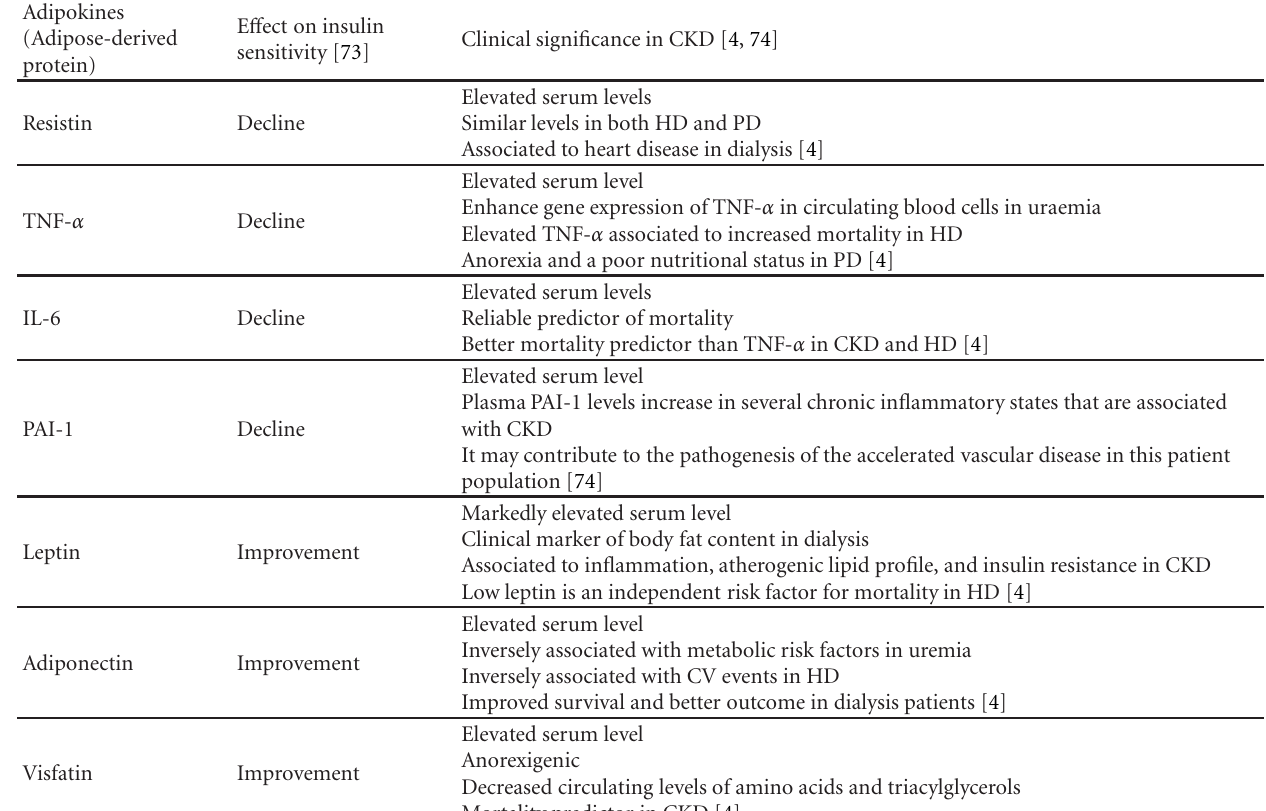
Table 3: The Adipokines e ff ect on insulin